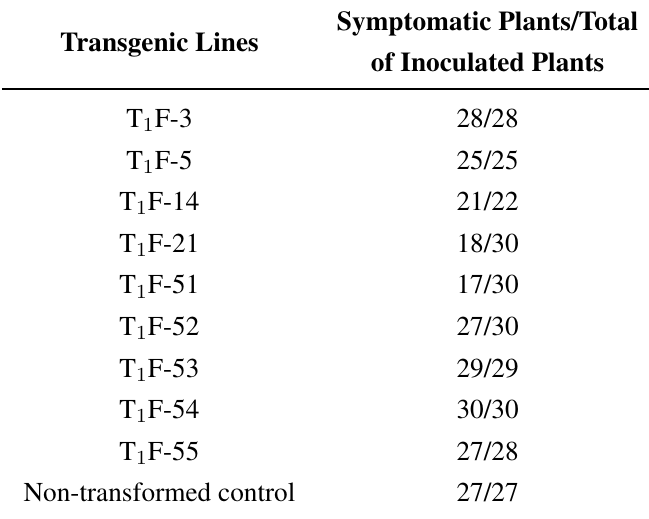
transgenic N. benthamiana plants inoculated with 1